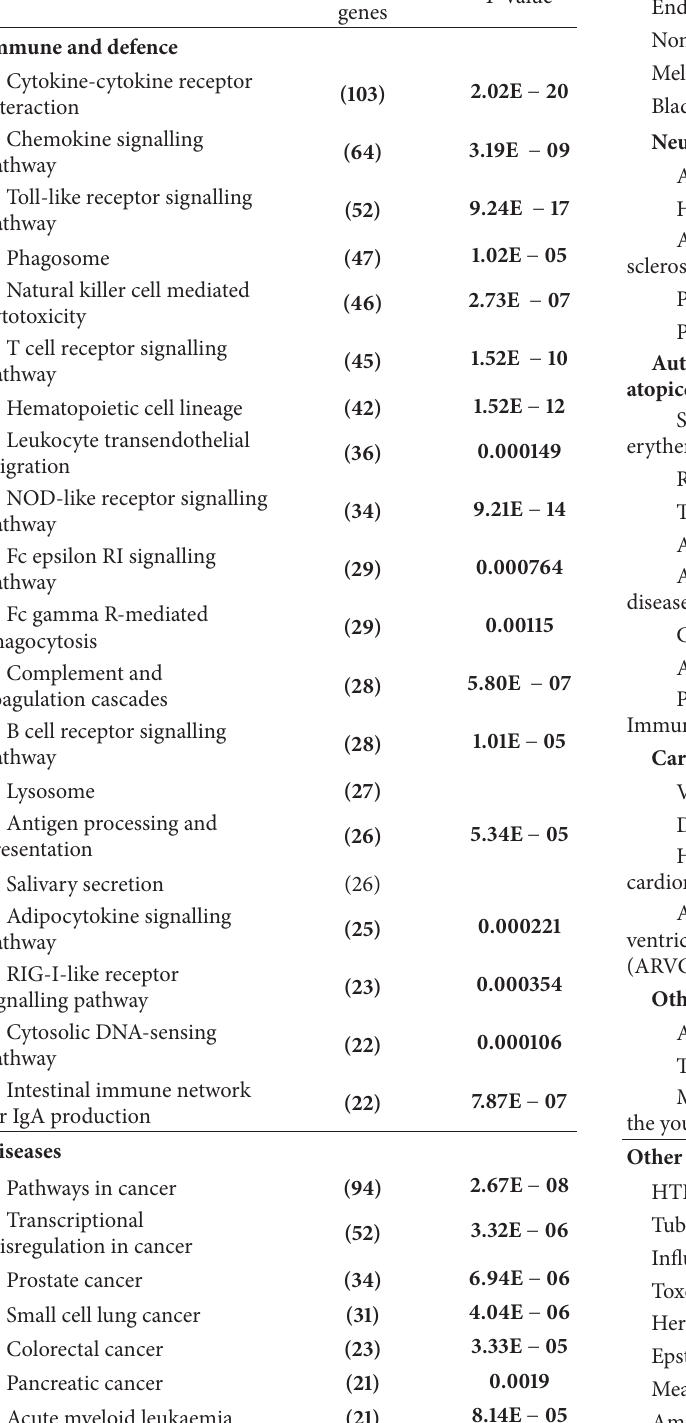
Table 1: Results of the KEGG pathway analysis of the T. gondii host/pathogen interactome (host genes): Immune and defence pathways, Diseases and other infections. The number of genes recovered in each pathway is in brackets and the enrichment 𝑃 value from the CPDB analysis, provided where available, and significant values highlighted in